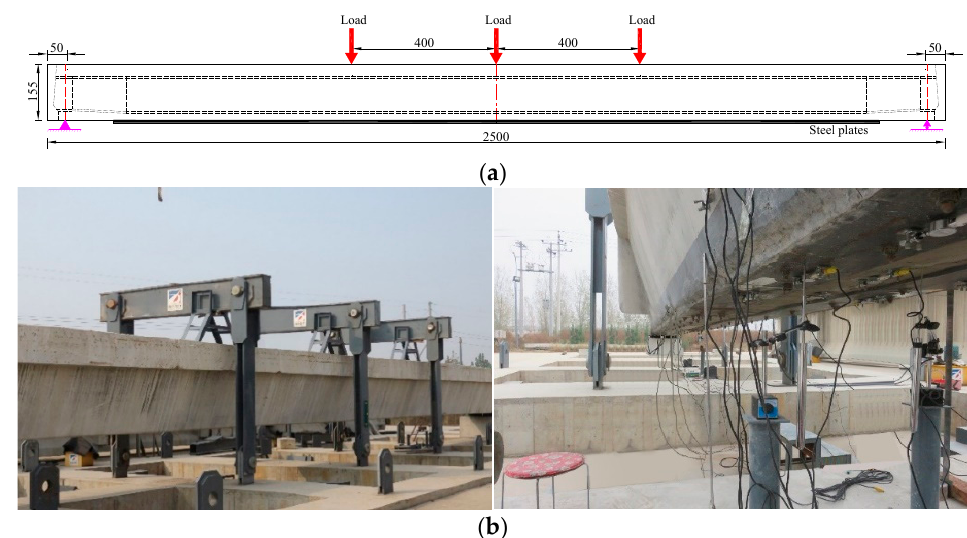
Figure 16. Loading layout of the destructive test. ( a ) Loading location (Unit: cm); ( b ) Field loading system.